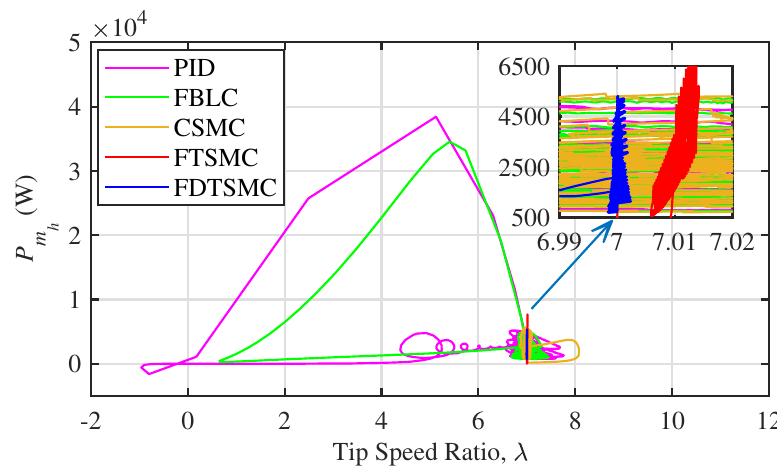
Figure 11. High-speed shaft mechanical power versus the tip speed ratio.